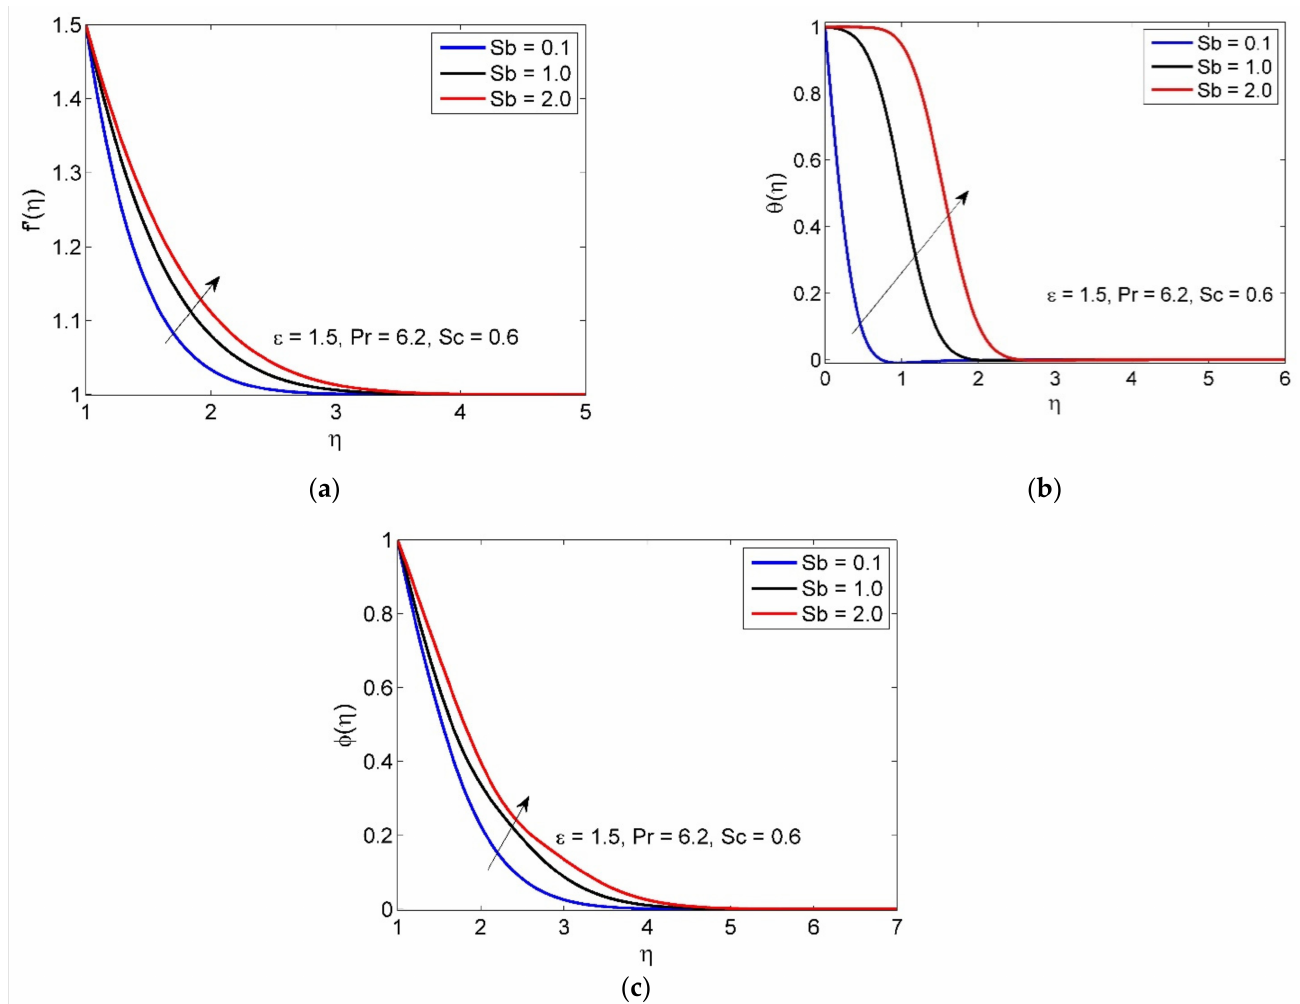
Figure 2. Influences of Sb on f (cid:48) ( η ) , θ ( η ) and φ ( η ) .